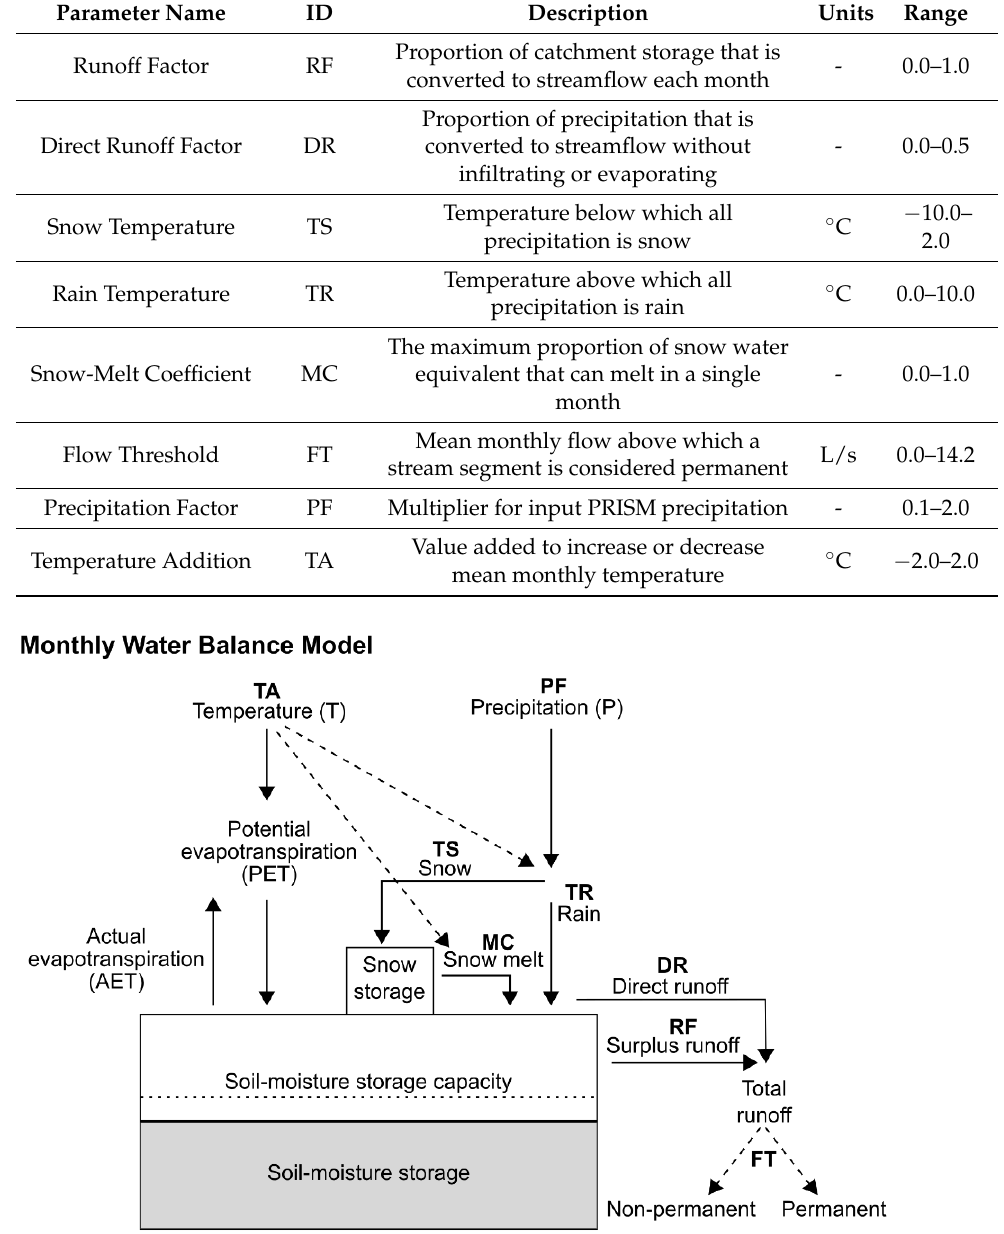
Figure 2. Diagram of the monthly water balance model. Bold parameter abbreviations correspond to the parameter descriptions and ranges in Table 1. Adapted from McCabe and Markstrom (2007)[10].